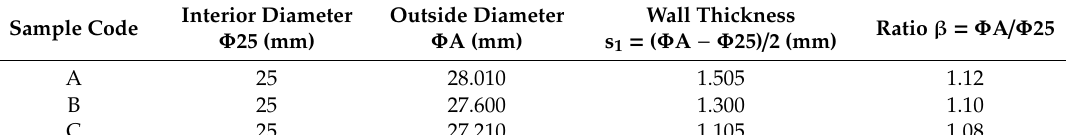
Figure 3. Variation of cyclic loading: zero-tension cycle.